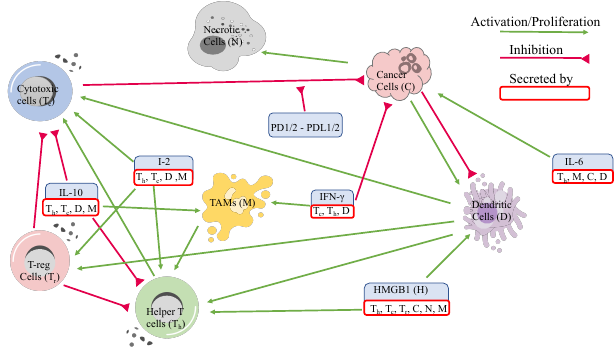
Figure 1. Tumor microenvironment interaction network of